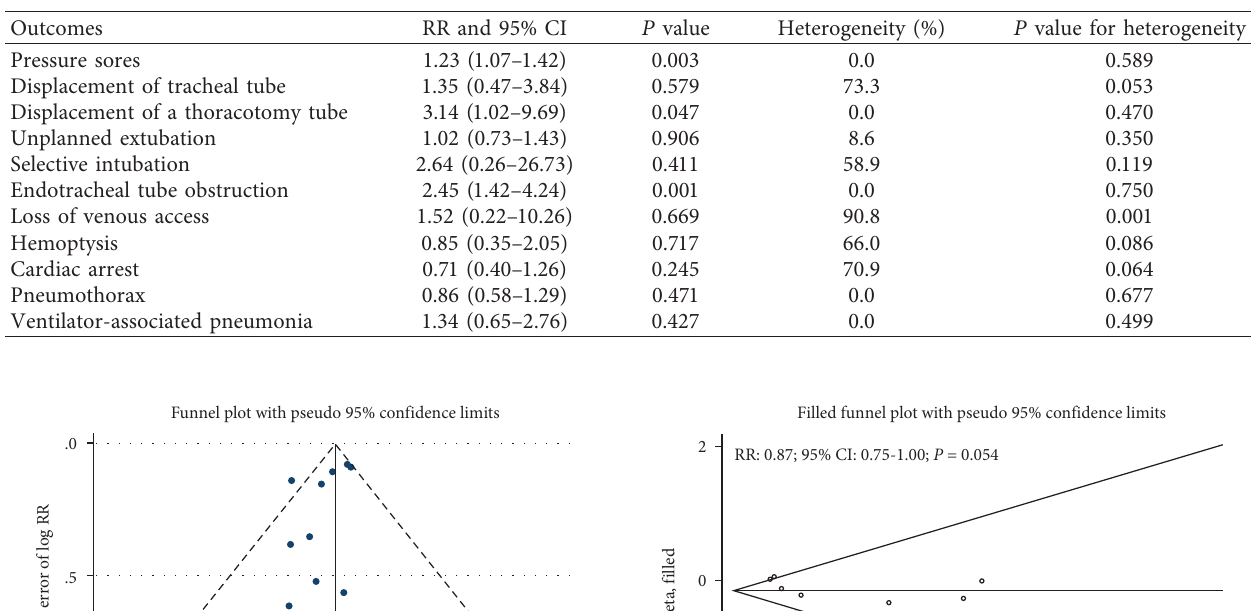
Table 4: The summary results for adverse events.